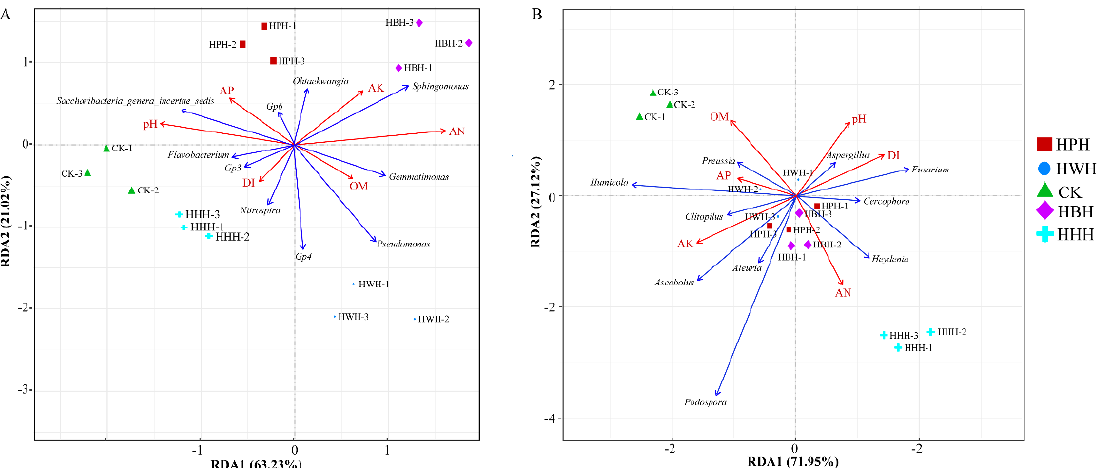
Figure 7. Redundancy analysis (RDA) showing interactions between soil characteristics and the top 10 bacterial genera ( A ) or fungal genera ( B ). pH denotes the soil pH; AP denotes available phosphorus; AK denotes available potassium; AN denotes alkaline hydrolysis; OM organic matter; DI denotes disease index (healthy plants as “0” and disease plants as “1”).